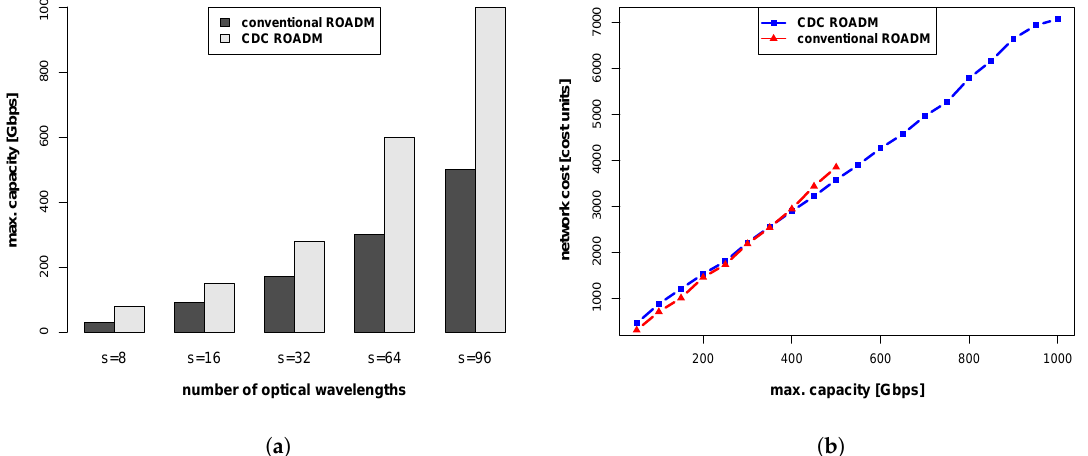
Figure 5. Dependence of maximum capacity of the network on the number of optical wavelength ( a ) and the dependence of network cost on maximum capacity of the network ( b ) for the Polish